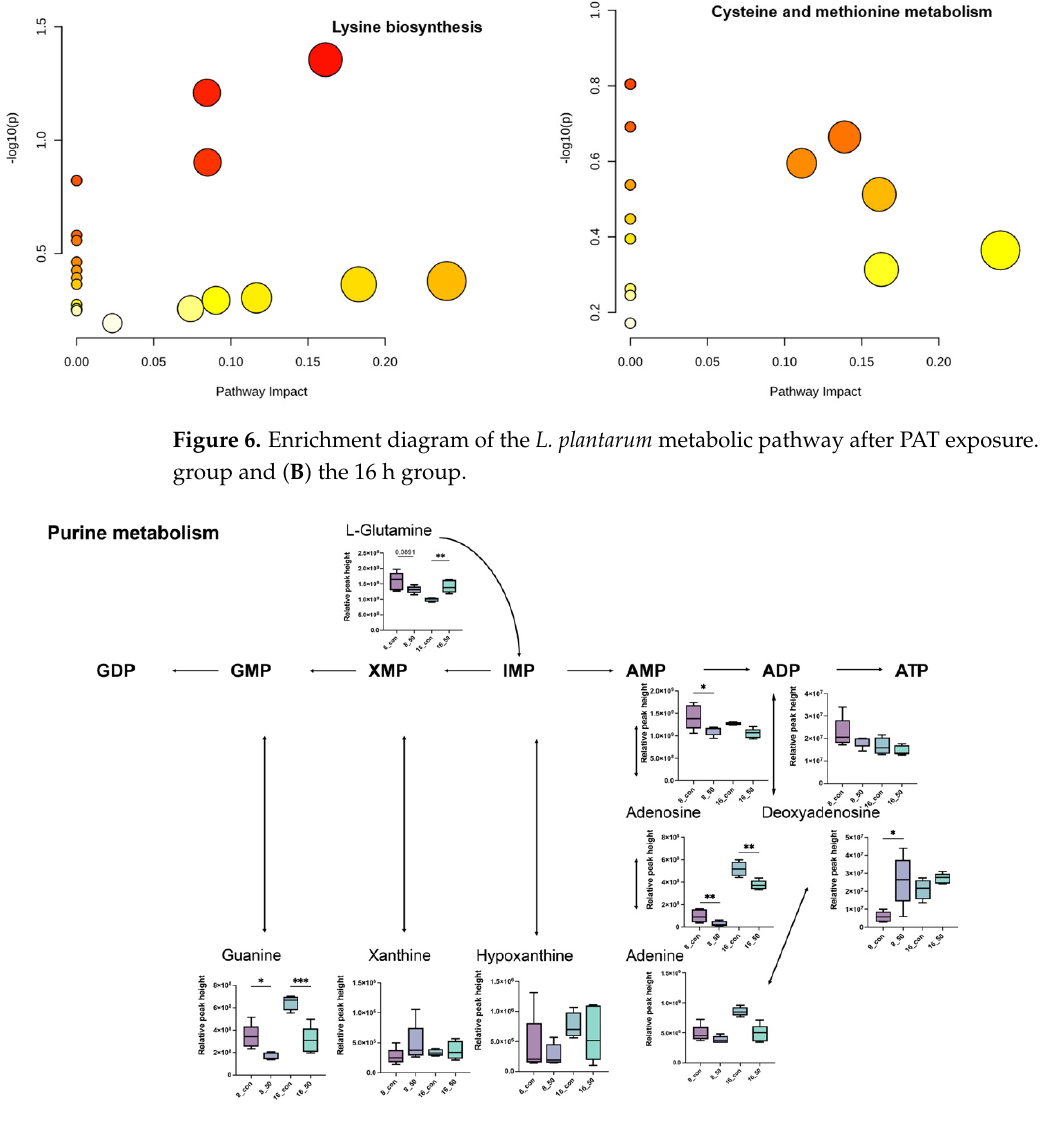
Figure 7. Intracellular purine metabolism pathway of L. plantarum CCFM1287 under (partial) PAT exposure. (* p < 0.05, ** p < 0.01, *** p < 0.001 vs. control group)